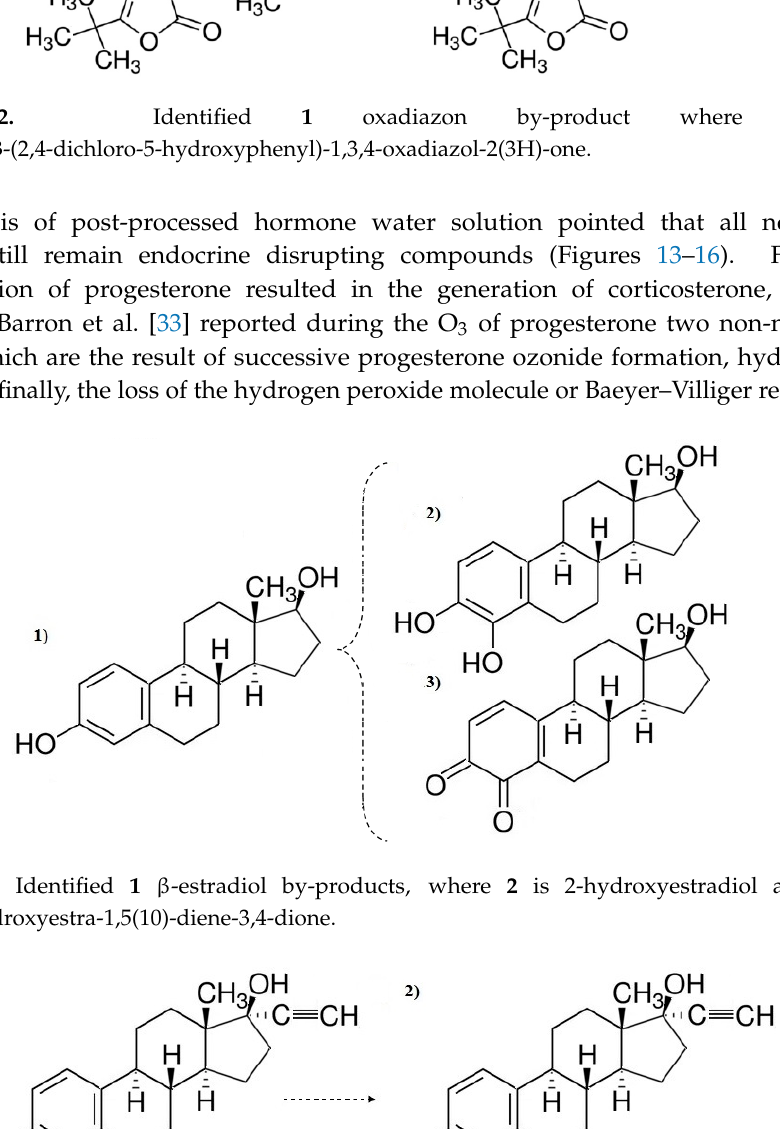
Figure 12. Identified 1 oxadiazon by-product where 2 is 5-tert-Butyl-3-(2,4-dichloro-5-hydroxyphenyl)-1,3,4-oxadiazol-2(3H)-one.